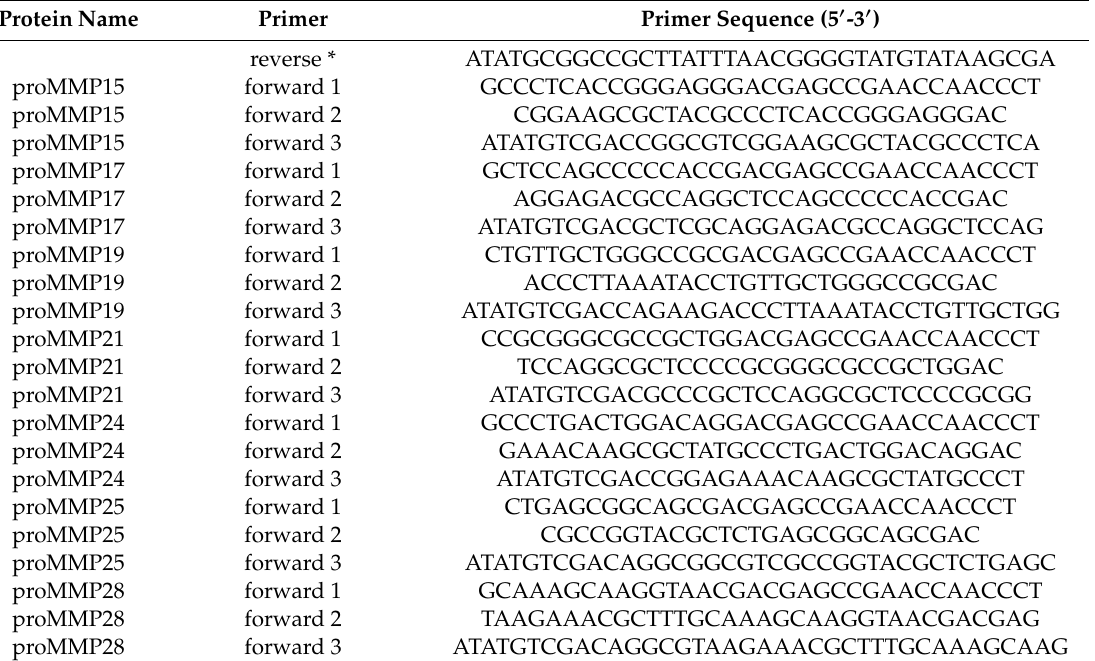
Table 3. Primers used for generating the proMMP CleavEx fusion proteins using three consecutive PCRs.